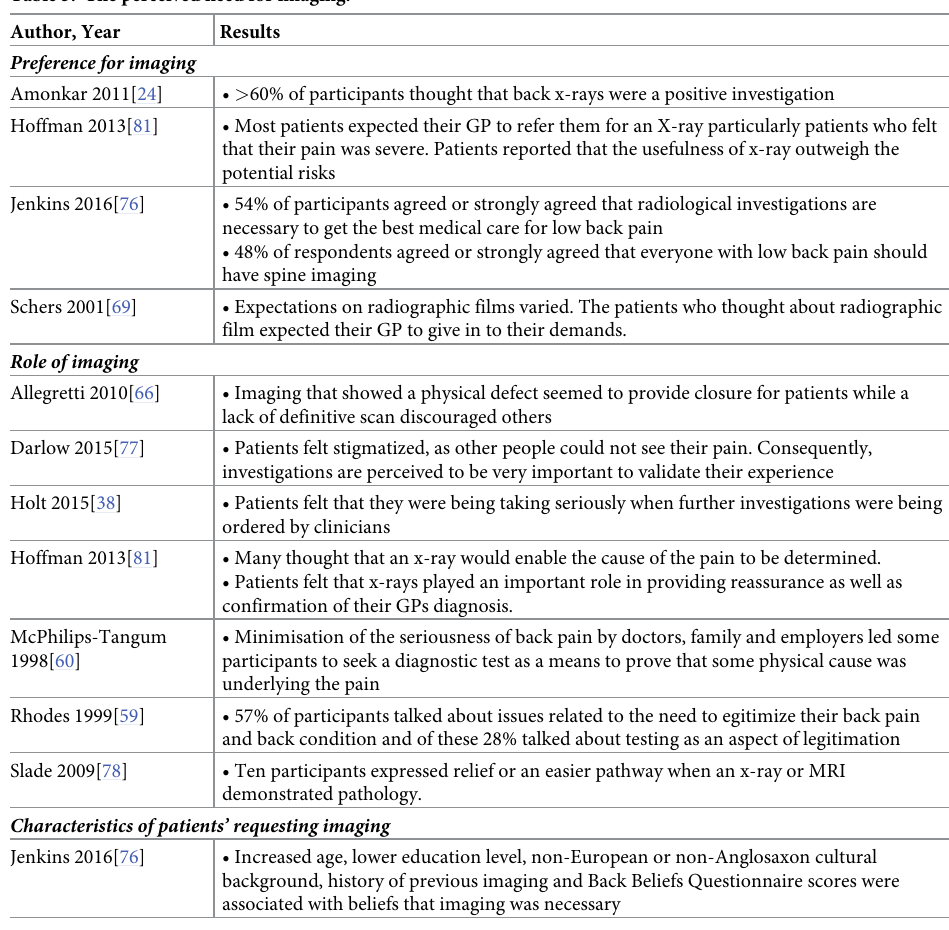
Table 5. The perceived need for